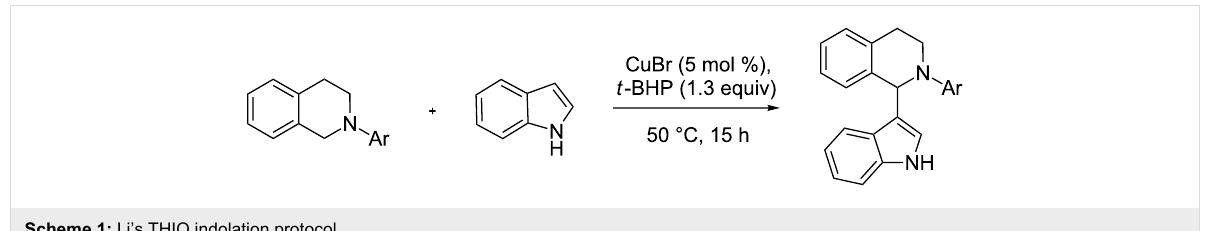
Scheme 1: Li’s THIQ indolation